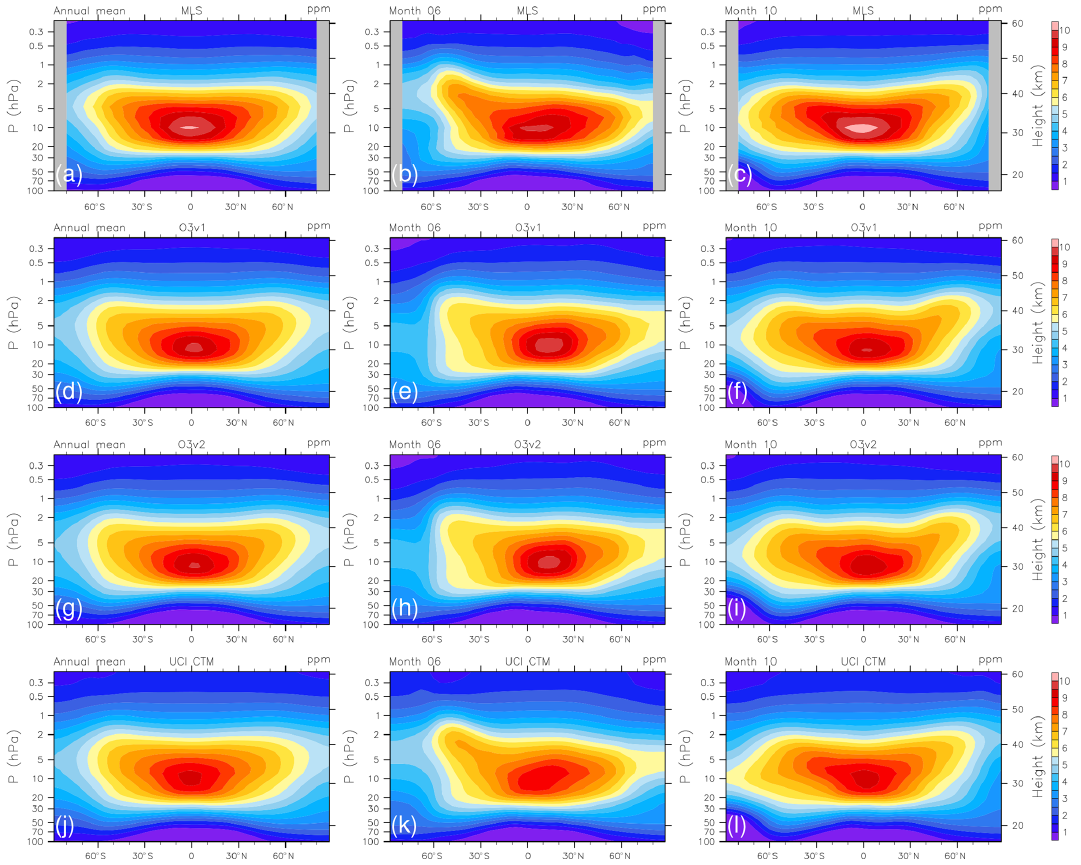
Figure 4. Latitude by pressure plots of multi-year zonal mean stratospheric ozone abundances (in parts per million mole fraction, ppm). The three columns show the annual mean, June values, and October values (left to right). The rows show MLS (years 2005–2019) observations, E3SM O3v1 (1995–2014), E3SM O3v2 (1995–2014), and UCI CTM (2005–2017) (top to